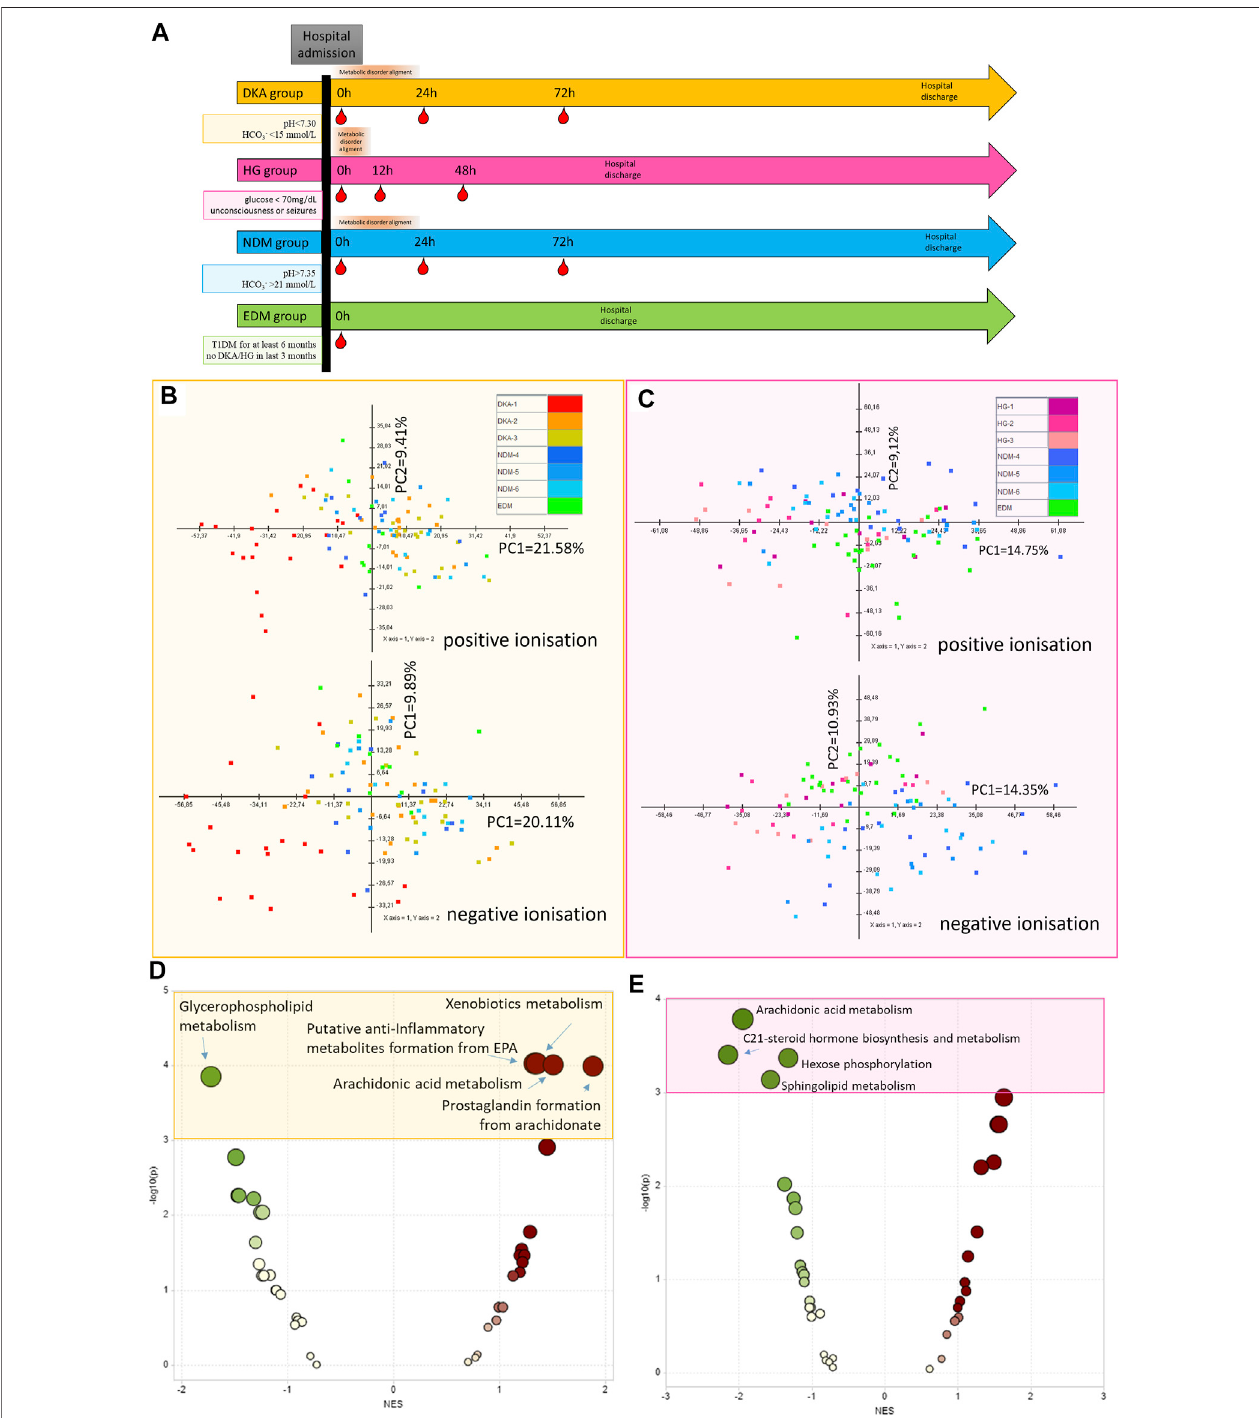
FIGURE1| Protocolforsamplecollectionforeachstudygroup(DKA,diabetesketoacidosis,HG,hypoglycemia)andeachcomparativegroup(NDM,newonsetof diabetes mellitus with DKA and EDM, established diabetes mellitus). Red droplets indicate the time points of blood withdrawal (A) . The principal component analysis of metabolic features passing technical data fi ltering for the DKA batch (B) and HG batch (C) . Metabolite Set Enrichment Analysis results based on results from the DKA batch(usingmetabolitesfromcombined comparisonbetweenDKA-2&DKA-3andNDM-4&NDM-5groupswith p < 0.15) (D) andtheHGbatch(usingmetabolites from combined comparison between HG-1&HG-2&HG-3 and EDM with p < 0.15) (E) .